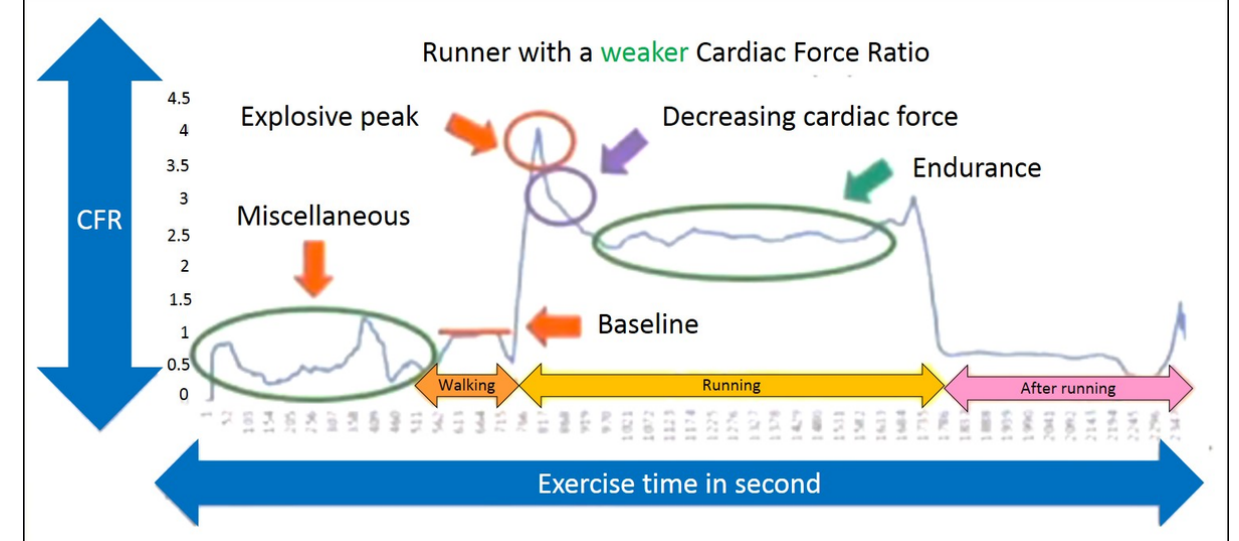
Figure 3. Runner with weaker cardiac force during 3000-meter